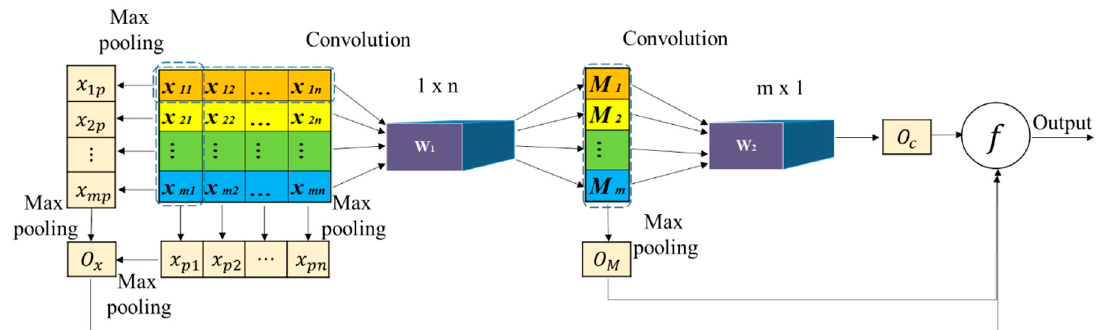
Figure 3. Schematic diagram of the CNN.